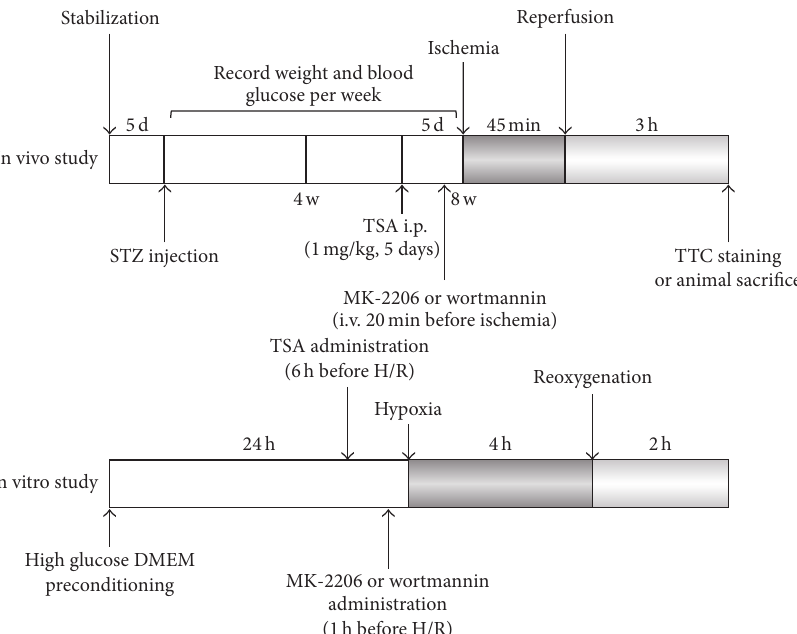
Figure 1: Experimental protocols. Diagram showing the experimental procedures including diabetes induction, ischemia/reperfusion model, TSA and MK-2206 administration, and sacrifice end point. Eight weeks after STZ injection, rats were subjected to 45min of coronary artery occlusion followed by 3 h of reperfusion. TSA or DMSO was administrated at 48, 24, and 1h before surgery. MK-2206, wortmannin, or vehicle was applied intravenously 20 minutes before ischemia. TSA: HDAC inhibitor; MK-2206: Akt